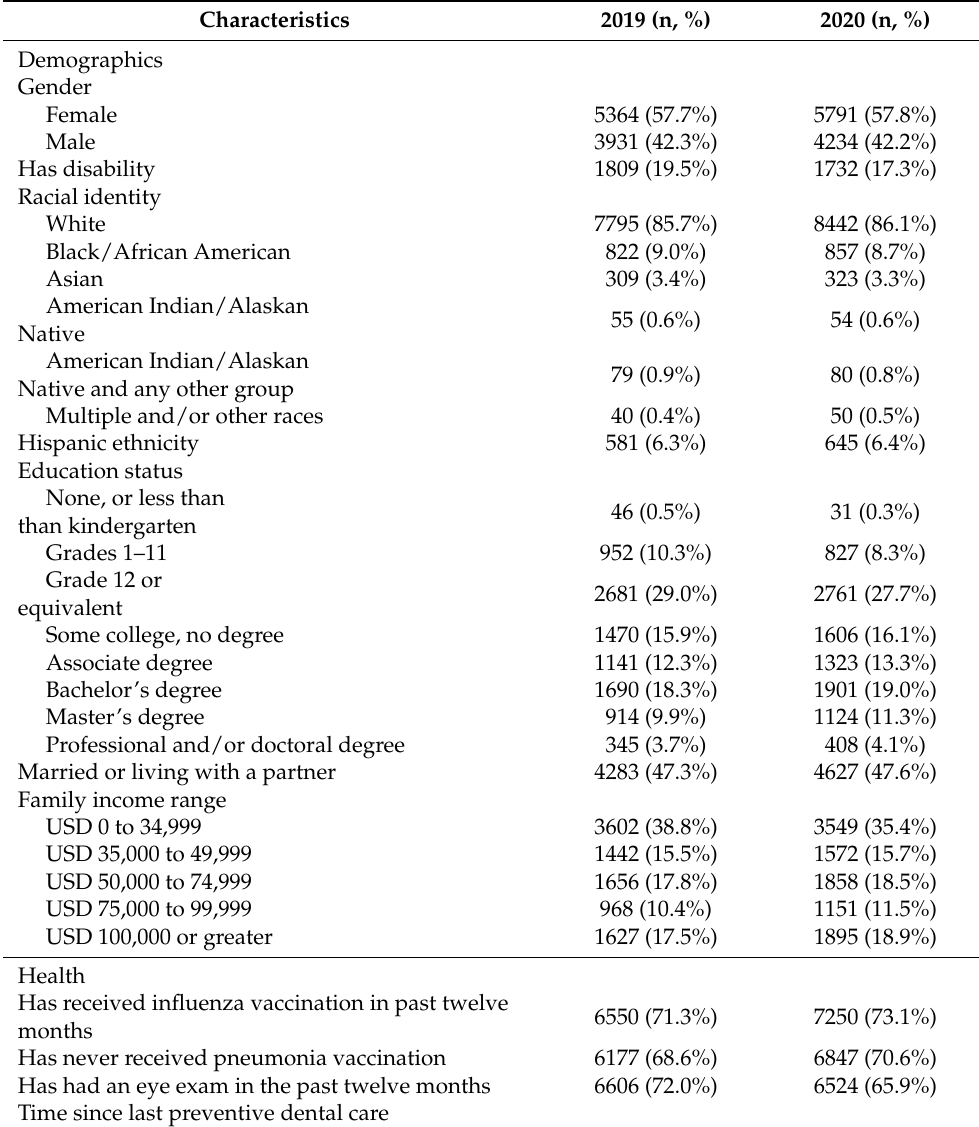
Table 1. National Health Interview Survey sample